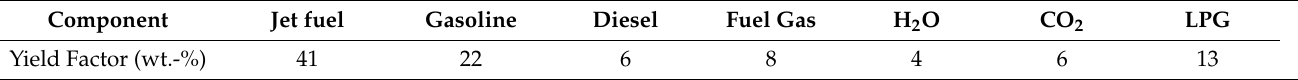
Table 4. Yield factors for the upgrading of bio-oil (data adapted from